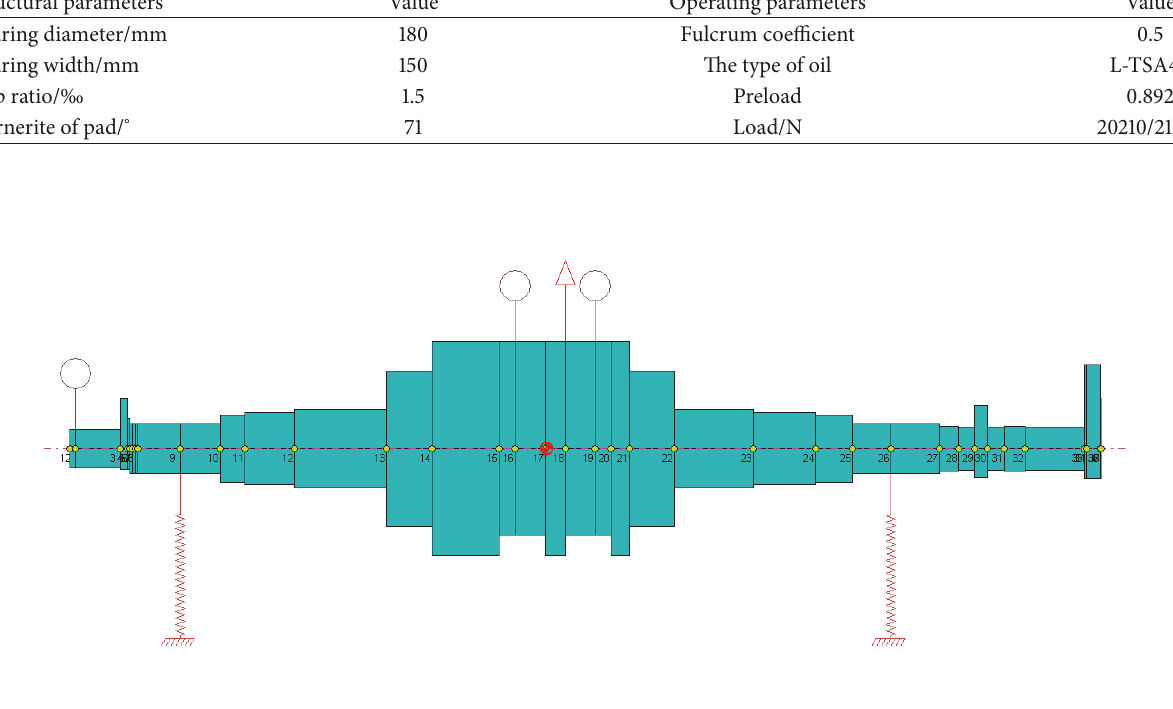
Figure 1: TRT rotor